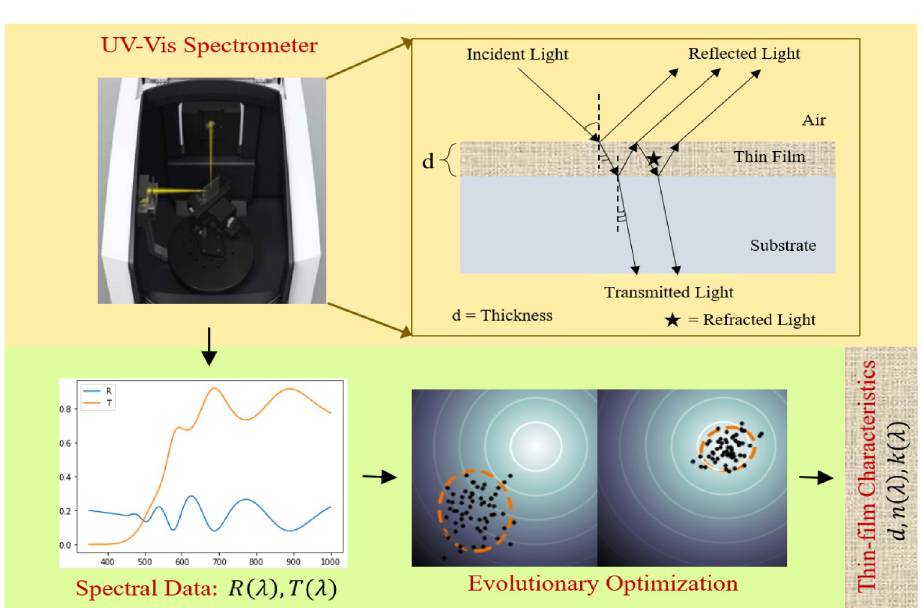
Fig 1. A flow diagram of the forward and inverse processes: (a) The forward process (yellow panel) involves an UV-Vis-NIR Spectrometer to measure the reflectance & transmittance { R ( λ ), T ( λ )} resulting from a film of thickness d nm and complex refractive index: n ( λ ) + ik ( λ ), (b) The inverse problem (green panel) is to find the desired optical parameters { d , n ( λ ), k ( λ )} from the measured data { R ( λ ), T ( λ )}.